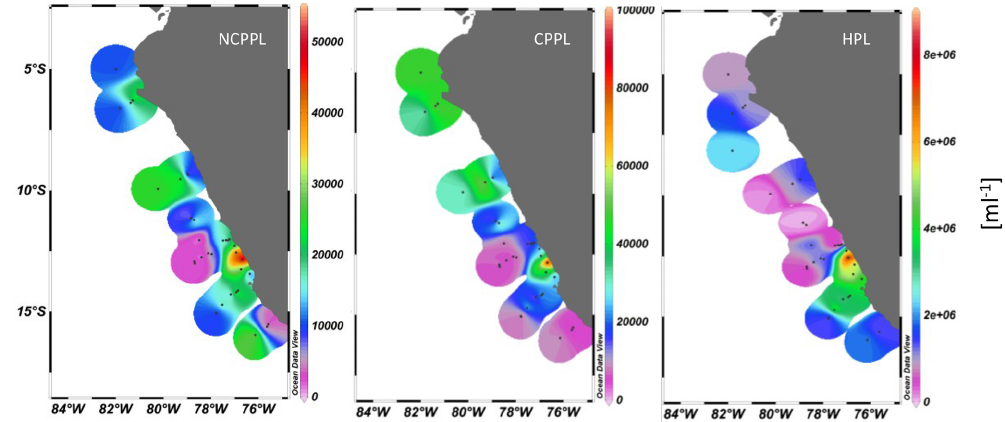
Figure 4. Phyto- and bacterioneuston (<20µm) abundance (numbermL − 1 ) in the SML off the coast of Peru during M93: NCPL: “Non- cyanobacterial-type” phytoplankton; CPL: “cyanobacterial-type” phytoplankton; HPL: heterotrophic